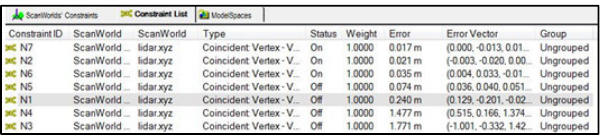
Figure 12. The result of integration process for all 7 points of man-made can achieve below 0.04m.